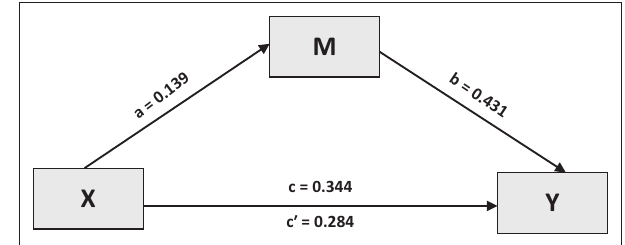
FIGURE 3: A simple mediation model.